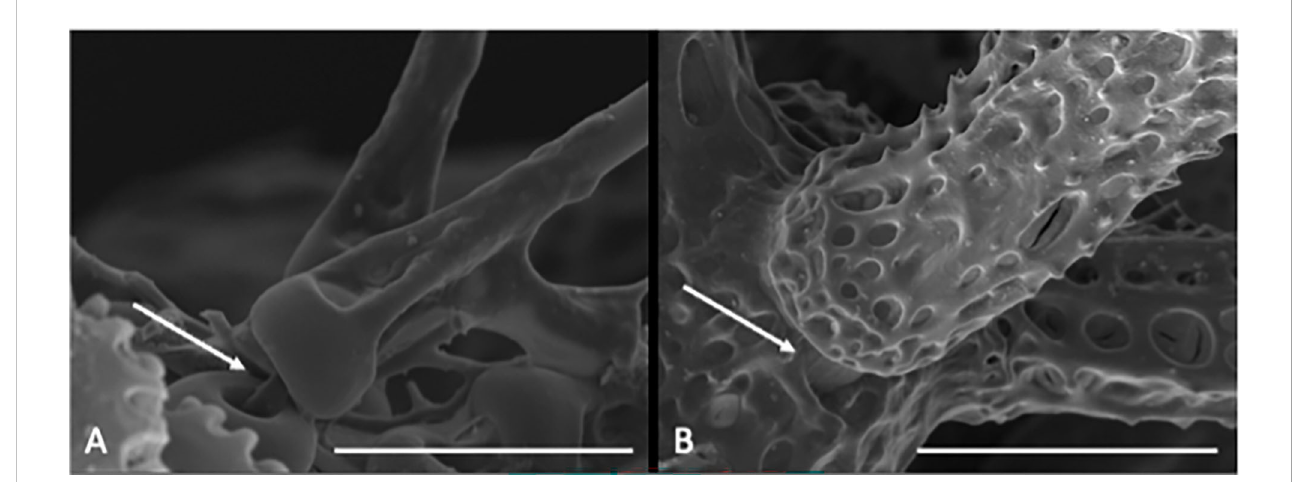
FIGURE 2 Scanning electron microscope images of close ups from the habitus of Ophiotholia saskia sp. nov. SO240_46_5. (A) Possible muscular connection between the parasol spine and its articulation. Scale = 50 µm (B) Muscular connection between arm spine and its articulation. Scale =